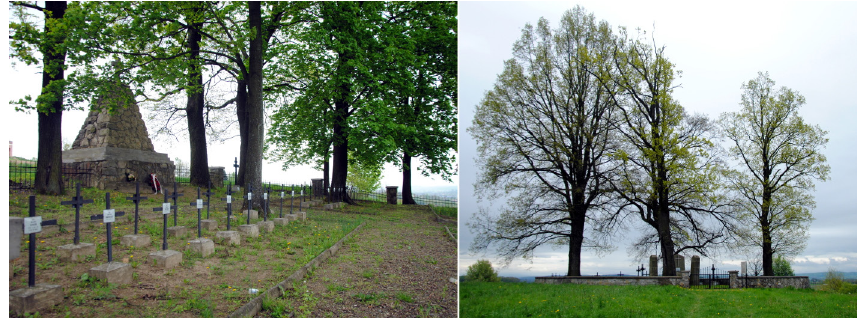
Fig. 2. Johann Jäger projects: Sławęcin no. 26 (left) and Bierówka no. 20 (right). Bierówka can be a